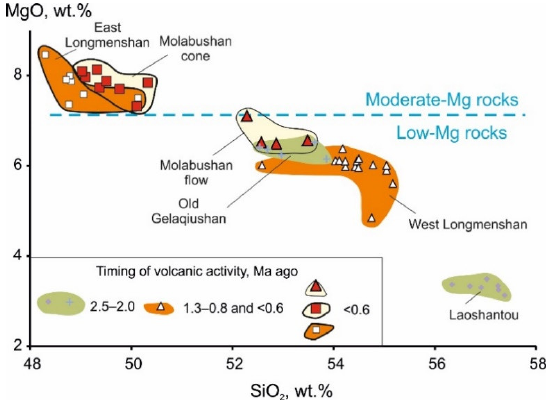
Figure 5. Variations of MgO versus SiO 2 in low- and moderate-Mg rocks from the Molabushan and Longmenshan volcanoes compared to those from older lava flows. The data used were from Table 2 and Tables S1. Anhydrous compositions were recalculated to 100%.